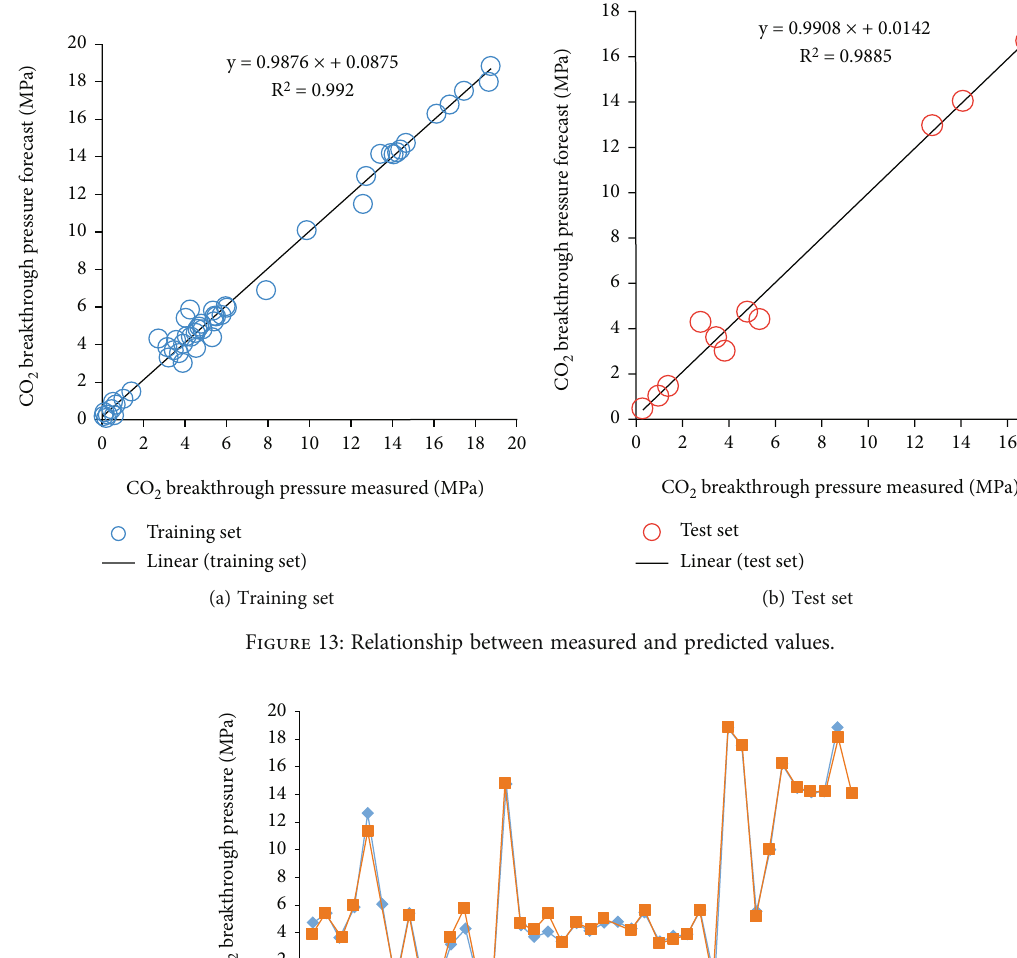
Figure 14: Comparison of the prediction results of the training